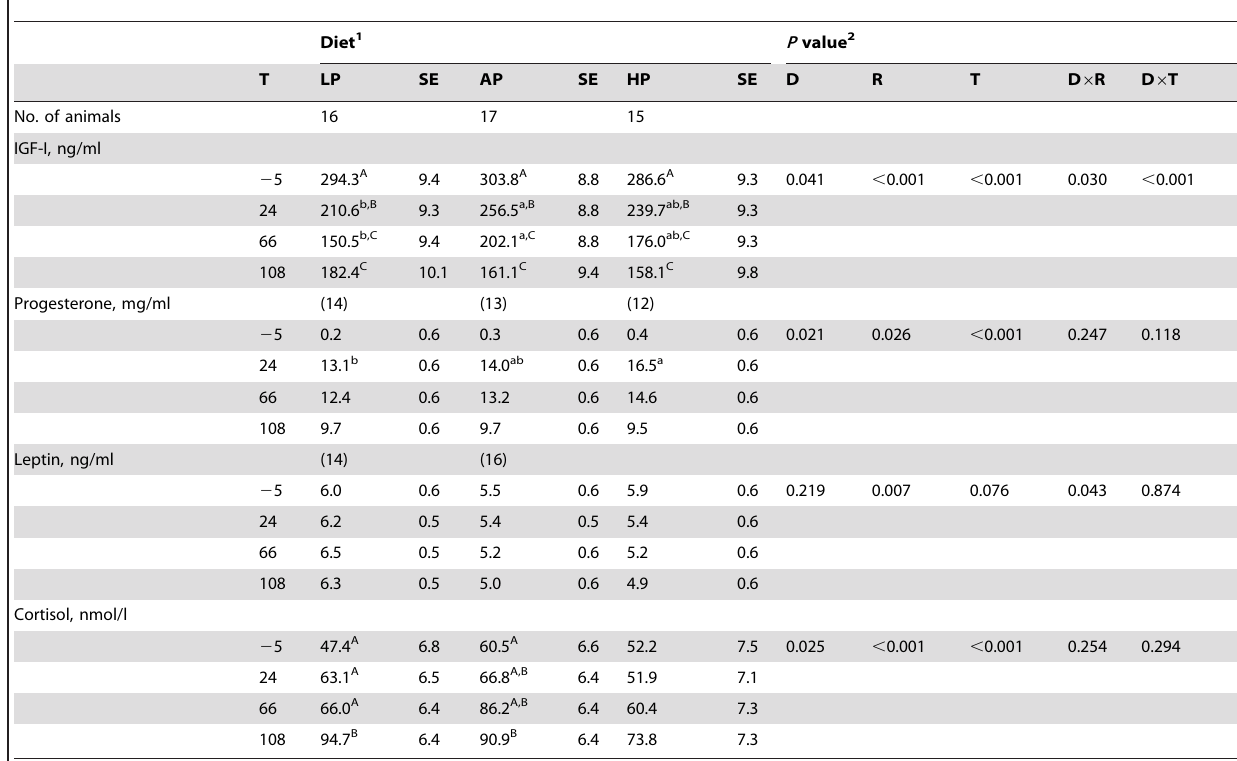
Table 5. Basal plasma IGF-I, progesterone, leptin and cortisol concentrations of sows at 5 days before and 24, 66 and 108 days after